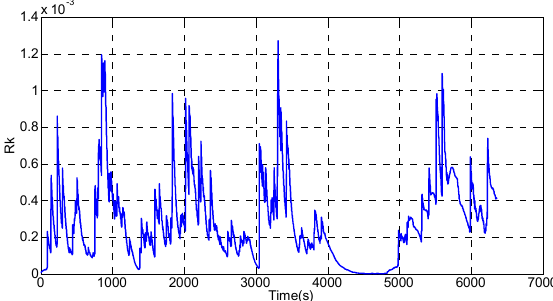
Figure 10. The R k variation when calculating the lowest cell SOC .